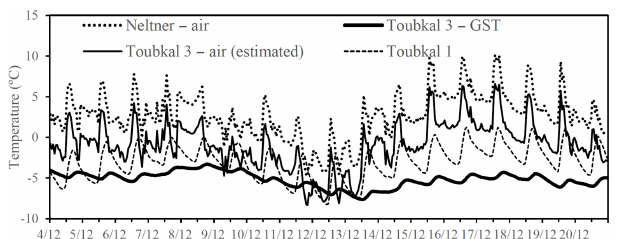
Figure 12. Example showing the estimated hourly GST regime at Toubkal 3 and comparison with air temperatures measured at Neltner and extrapolated to T3 using the observed lapse rate of − 0.59 ◦ C100m − 1